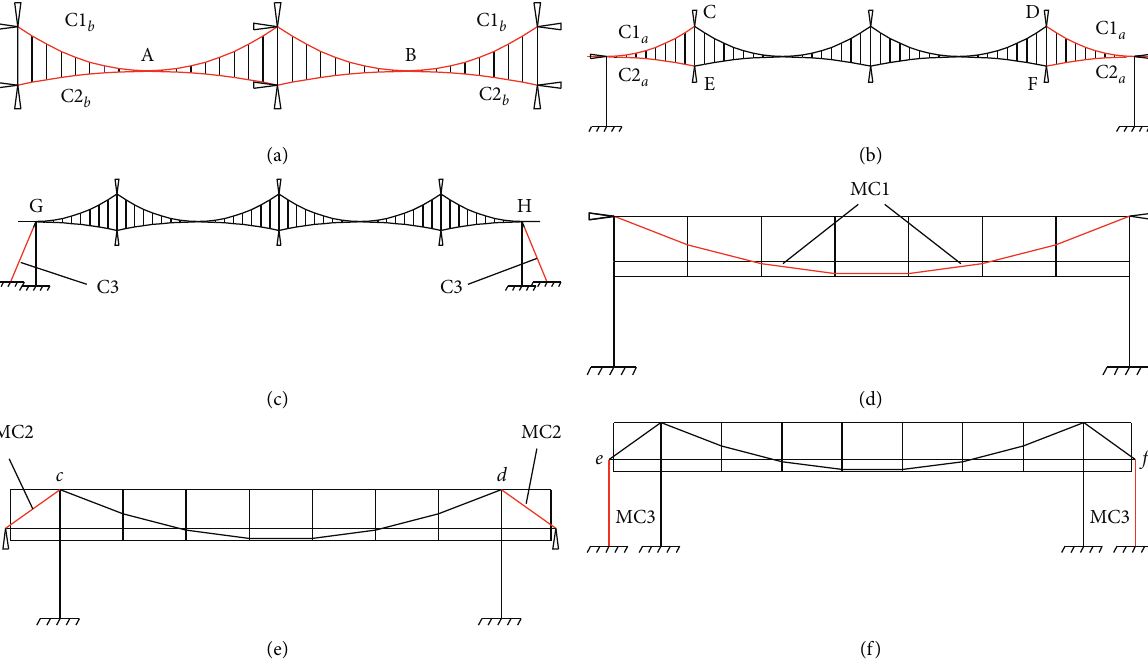
Figure 5: Operation process of substructures: (a) step 1, (b) step 2, (c) step 3, (d) step 4, (e) step 5, and (f) step